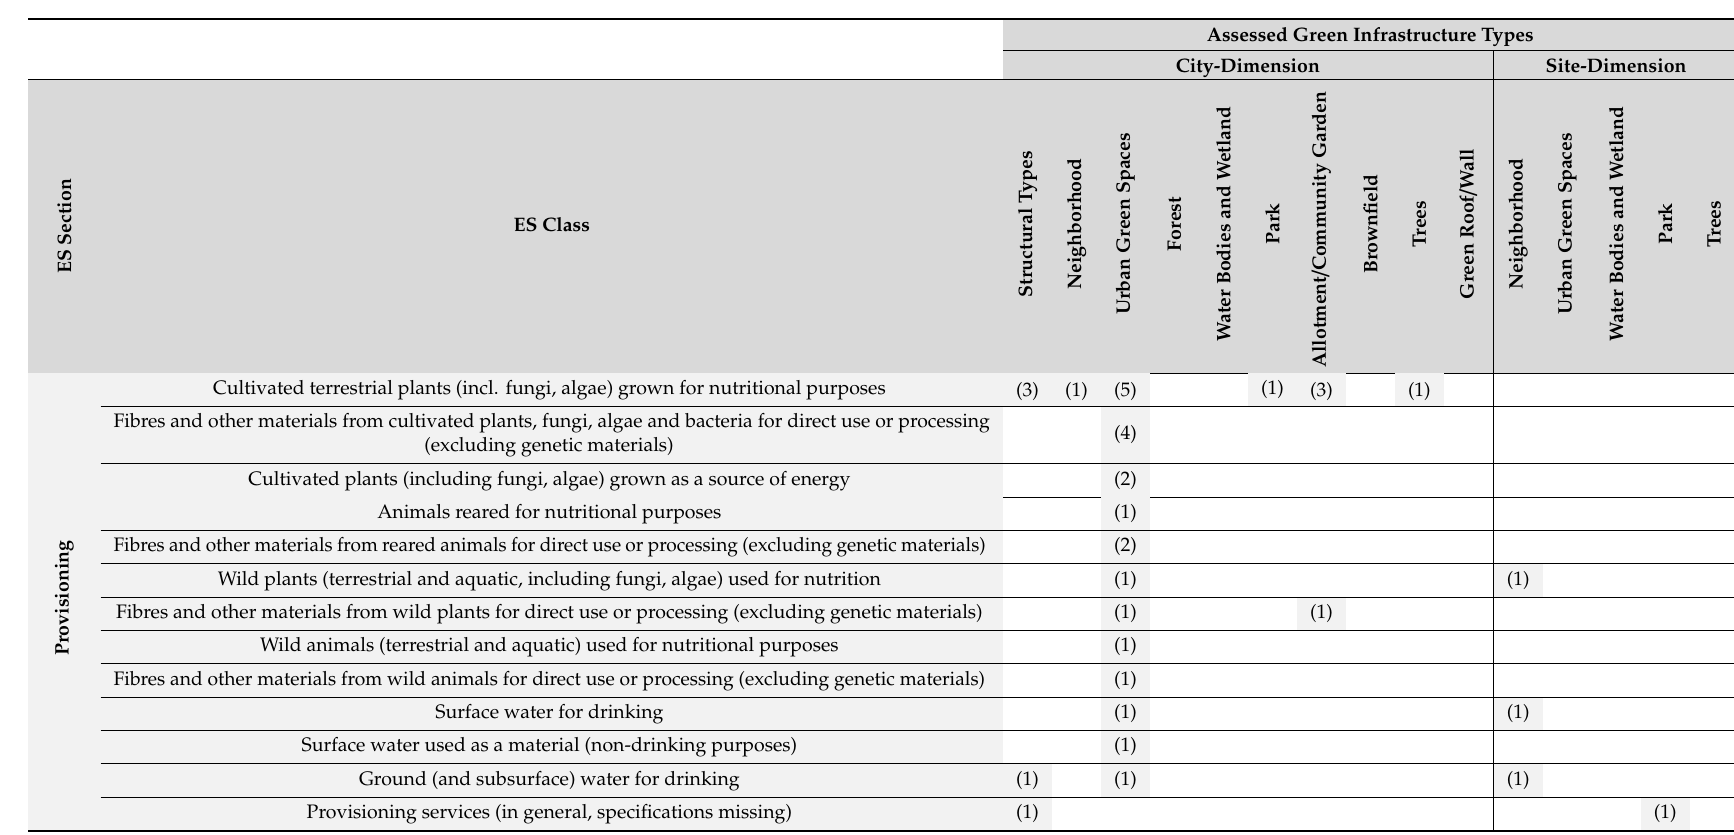
Table 3. Assessed ES classes according to CICES V5.1 in relation to the considered green infrastructure types. The figures in brackets indicate how often an ES was assessed for the corresponding spatial structure. Since multiple ES were analyzed in some articles, the sum in brackets is higher and does not represent the total number of articles reviewed. (Note: The specification of the considered ES class is missing in some articles; these were assigned to the ES section “in general, specifications missing” in each ES